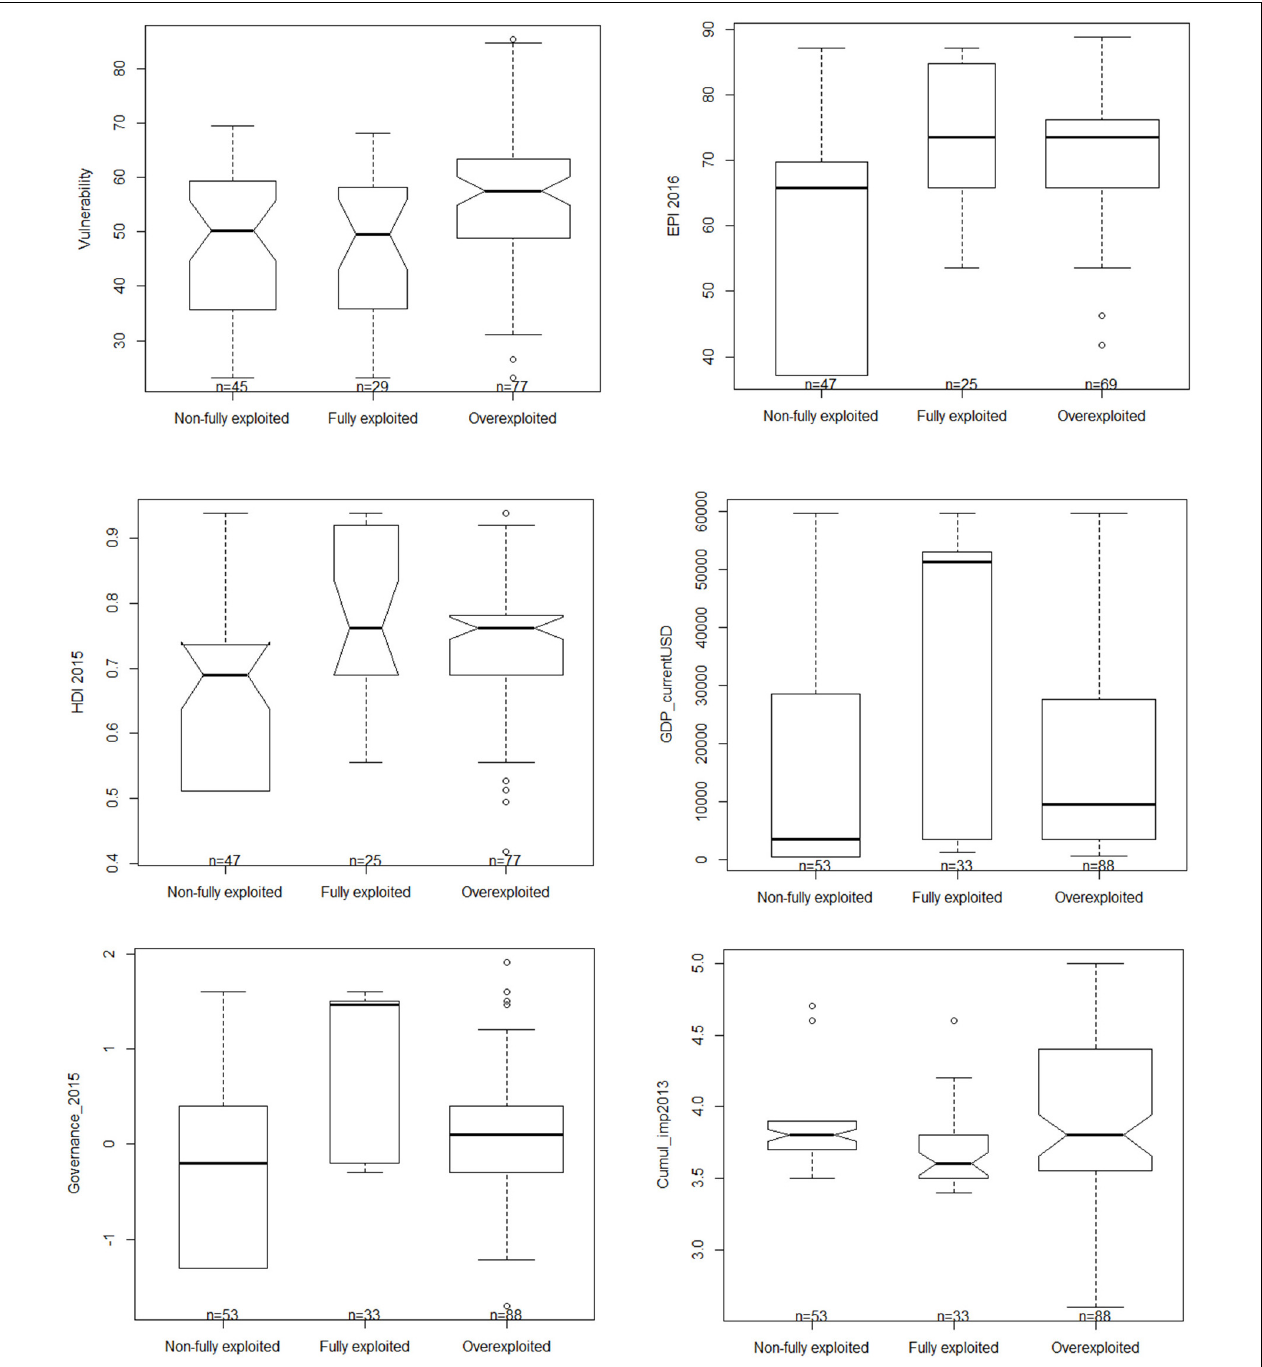
FIGURE 10 | Distributions of the biomass stock status categories (non-fully exploited, fully exploited, and overexploited) in relation to the variables that distinguish one category of biomass from the other two (significant differences p < 0.05). Notches were omitted when the confidence interval for the median was found to be greater than the interquartile range. EPI, Environmental Performance index; HDI, Human Development index; GDP_currentUSD, Gross Domestic Production per capita (current USD); Cumul_Imp, Cumulative Human Impacts to Marine Ecosystems score.